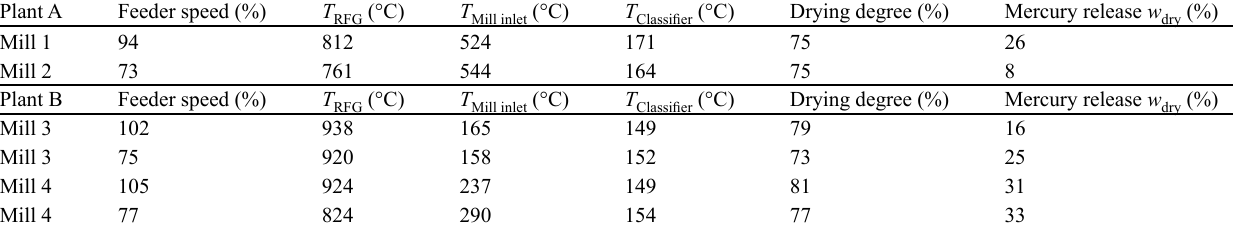
Table 4 Experimental conditions during lignite sampling at two lignite power plants Plant